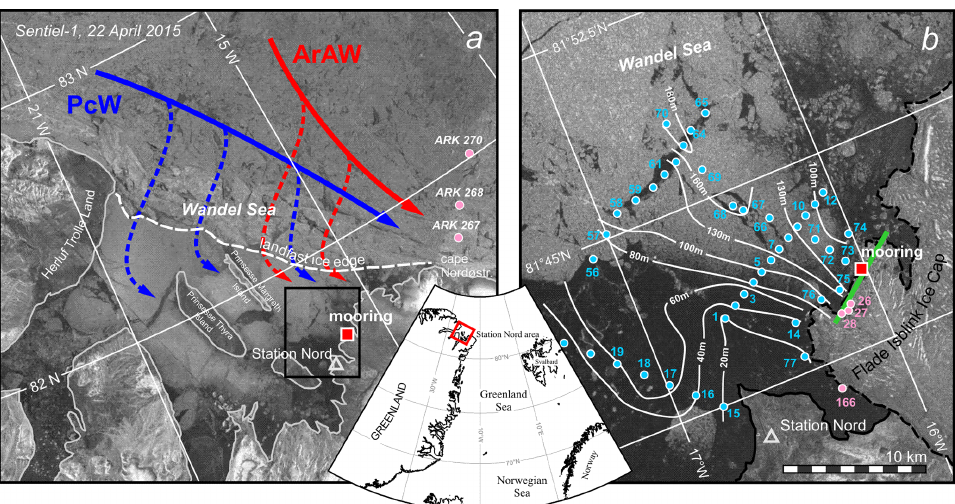
Figure 1. (a) The Wandel Sea region and (b) the bathymetry map near the Flade Isblink Ice Cap outlet shown for the area demarcated by the black rectangle in (a) . The red and blue arrows in (a) schematically indicate two major regional flows: the Arctic-derived Atlantic water (ArAW) and the Pacific water (PcW). The white contour lines show the bottom depth, whereas the black solid and dashed lines correspond to the coastline and glacier edge, respectively. Blue circles correspond to position of CTD stations in April–May 2015, while pink circles indicate the positions of supplemental CTD profiles conducted in August 2008 (ARK 267, 268, and 270), in August 2015 (st. 166), and in April 2016 (st. 26, 27, and 28). The red squares show the location of the ice-tethered mooring (21 April–10 May 2015) equipped with the ITP and ADCP. The green line indicates the approximate orientation of the glacier terminus in vicinity of the mooring